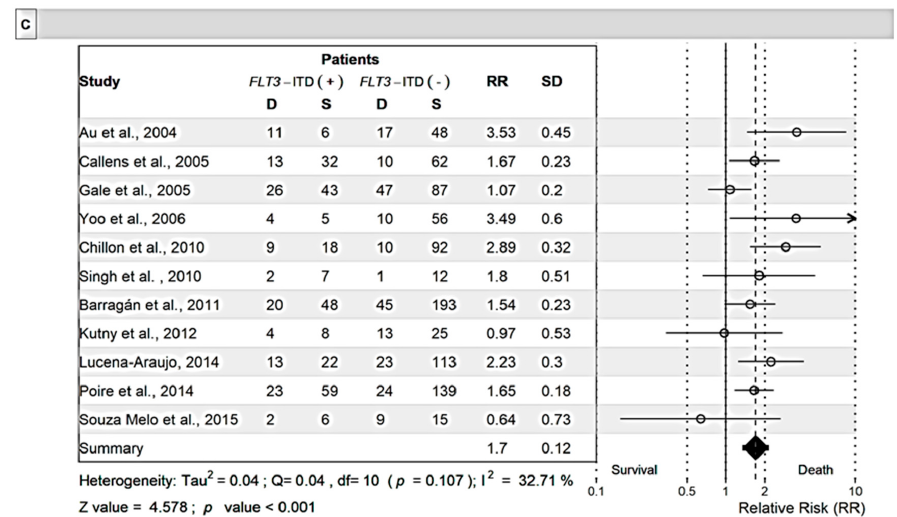
Figure 4. Meta-analysis of the relative risk for patients with the FLT3 -ITD mutation. Induction death